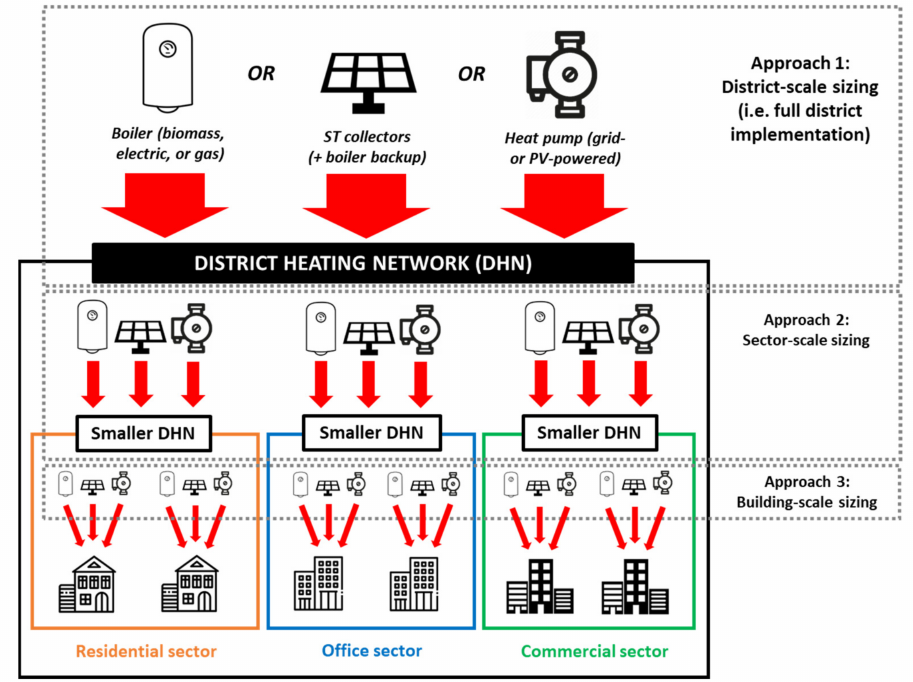
Figure 2. Schematic representation of the three approaches considered for sizing the heat production